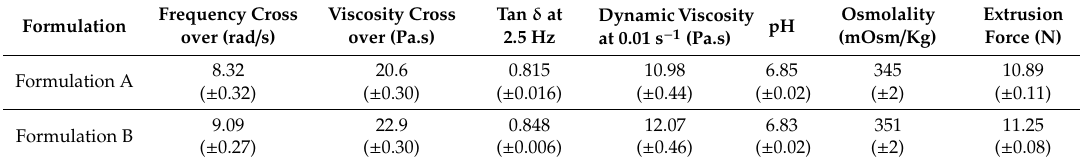
Table 5. Experimental parameters of the optimized formulations (mean values ± s.d.; n = 4).